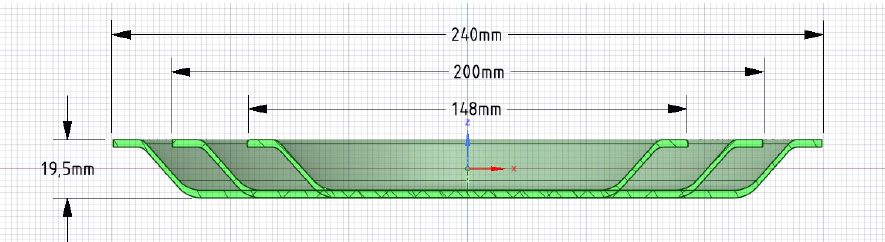
Fig. 2. Model for determining the volume of plates with various diameters (see Table 1).